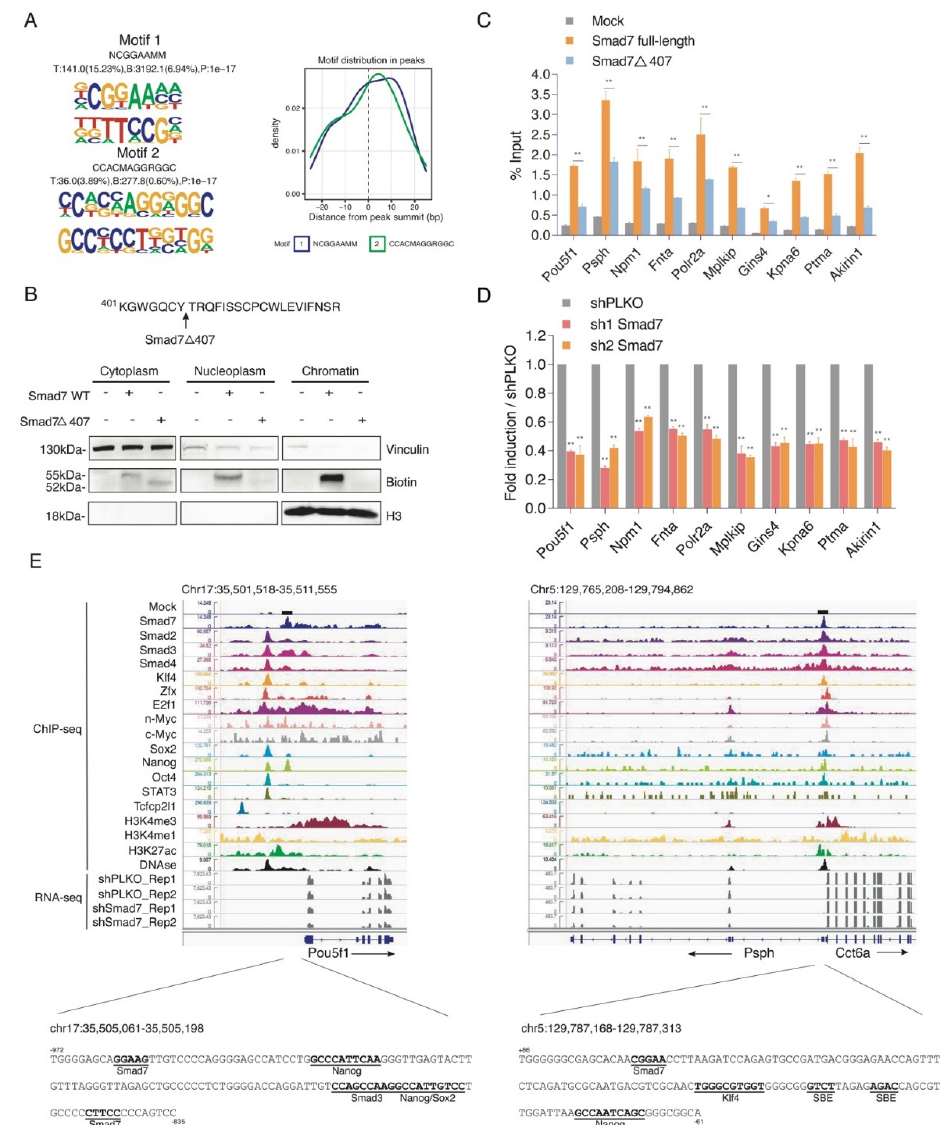
Figure 3. Smad7 binds to the promoters of genes involved in ESC self ‐ renewal. ( A ) Left panel: De novo DNA sequence motifs and their STAMP logos and enrichment statistics, including observed binding sites. Occupancy signals within ± 25 bp of the Smad7 peak summit are shown. ( B ) Top panel: Schematic of the mutant of Smad7 (Smad7 Δ 407), which lacks the last 19 amino acids at the C terminal. Smad7 Δ 407 construct also has an Avi ‐ tag at its N terminal. Bottom panel: Western blot showing the subcellular fractionation of Smad7 WT and Smad7 Δ 407. Biotin antibody was used to compare the expression of exogenous (bio ‐ tagged) Smad7 WT and Smad7 Δ 407 in three fractions of cells. BirA cells, Smad7 WT, and Smad7 Δ 407 transfected cells were used in this experiment. Vinculin was used as a cytoplasm marker, and H3 was used as a chromatin marker. ( C ) RT ‐ qPCR analysis of BioSmad7 WT and Smad7 Δ 407 ChIP samples at the promoters of the indicated genes. The results are shown as the percentage (1/100) of the input. Data are shown as mean ± SEM; n = 3. ** p < 0.01. * p < 0.05. ( D ) RT ‐ qPCR analysis of the indicated transcripts upon a knockdown (KD) of Smad7 proteins. The results are shown as fold difference normalized to shPLKO. Data are shown as mean ± SEM; n = 3. ** p < 0.01. ( E ) Representative genomic occupancy profiles of genes identified by BioSmad7 ChIP ‐ Seq. IGV images showing the comparison of ChIP ‐ seq peaks of Smad7 binding (current study), other 14 factors (accession code GSE11431, GSE125116), the locations of histone H3 modifications (accession code GSE12241, GSE11172, and GSE31039), DNAse, and RNA ‐ seq of two independent experiments of Smad7 knockdown (current study) at genes downregulated by Smad7 knockdown. Two examples ( Pou5f1 and Psph ) are shown. The genes and their direction of transcription are indicated by arrows. The binding loci of Smad7 are indicated by black boxes. Putative transcription factor binding sites are annotated in bold black.